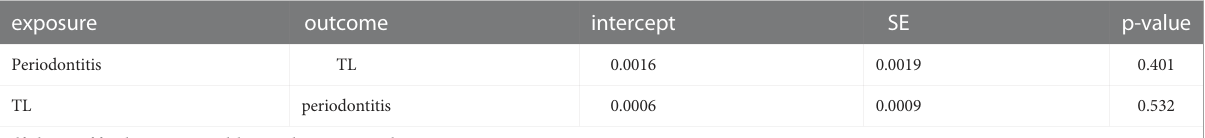
TABLE 1 MR-Egger test for directional pleiotropy.